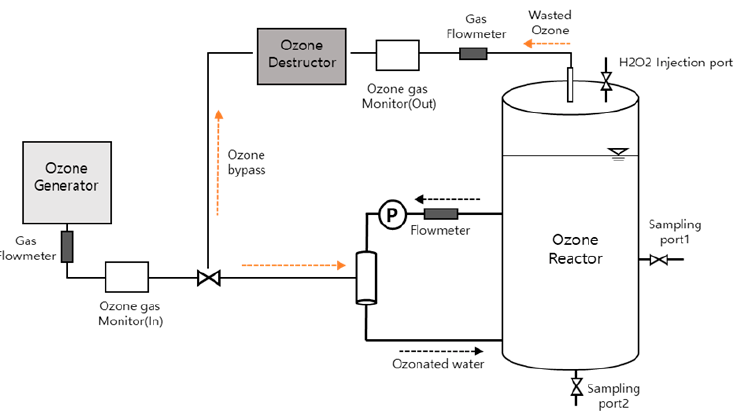
Figure 1. Schematic diagram of experimental setup.